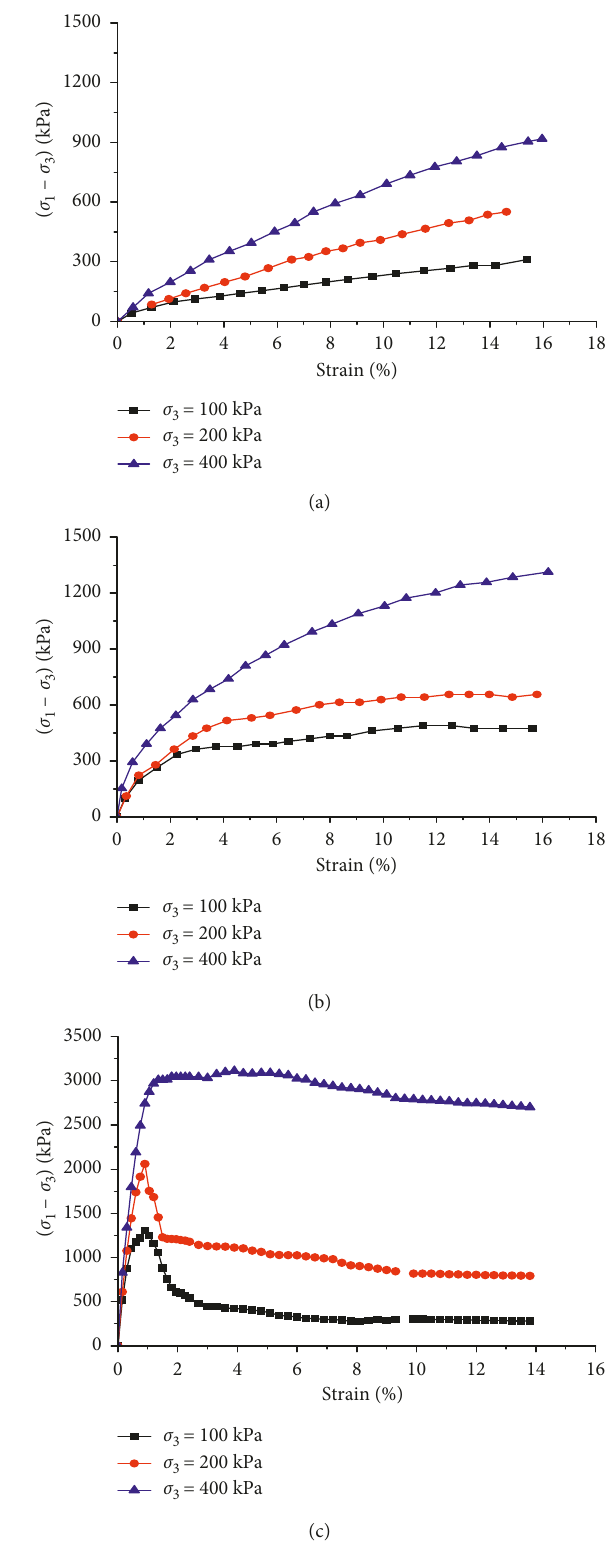
Figure 6: Triaxial stress-strain curves of the tested samples: (a) Bayer red mud from wetting process, (b) Bayer red mud from drying process, and (c) sintering red